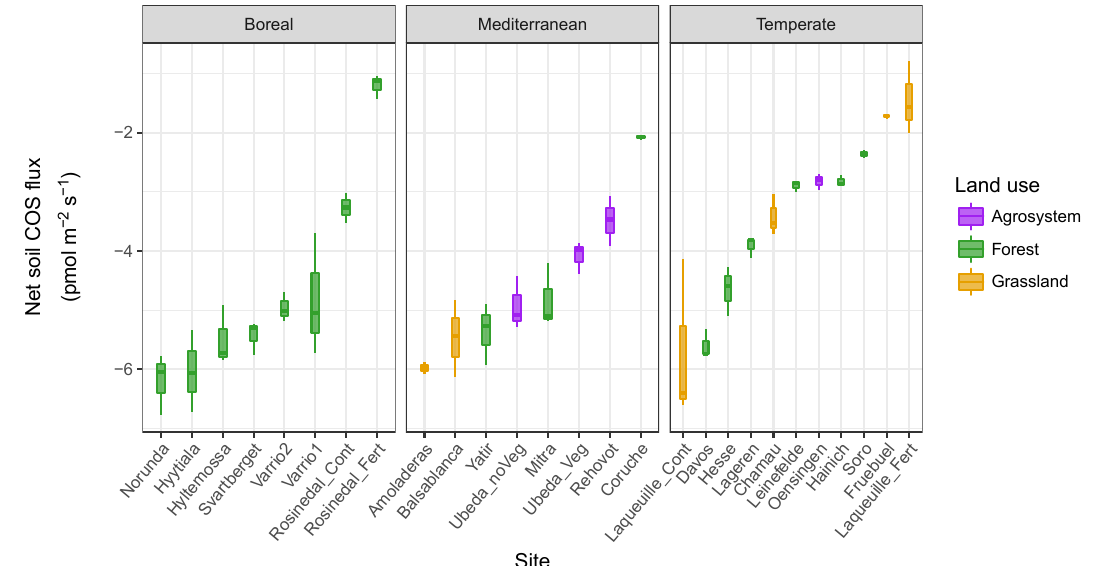
Figure 1. Variability in the net COS flux measured at 18 ◦ C and at an atmospheric COS concentration of 500ppt on replicated ( n = 3) moist (30% WHC) soils sampled from across Europe and Israel (see Table 1). Net COS fluxes were not significantly different between biome or land